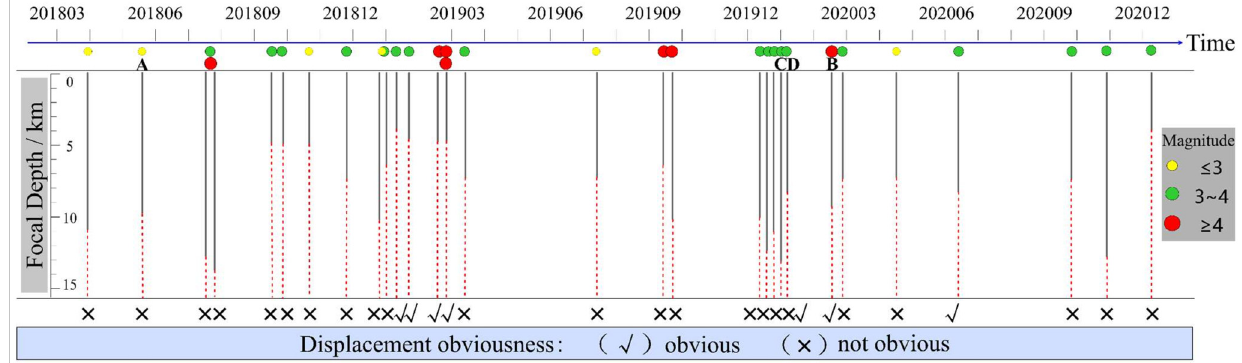
Figure 6. Timeline of all earthquakes with information on surface displacements, earthquake magnitude, and focal